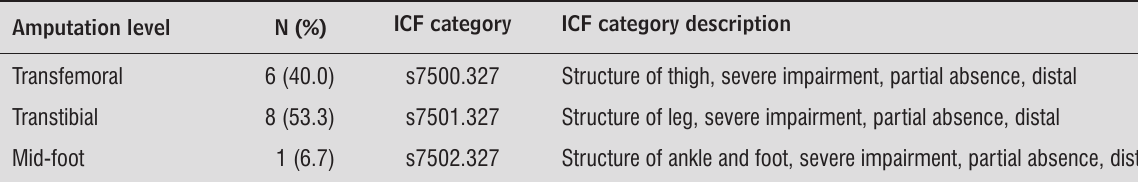
Table 1 - ICF categories for amputation levels